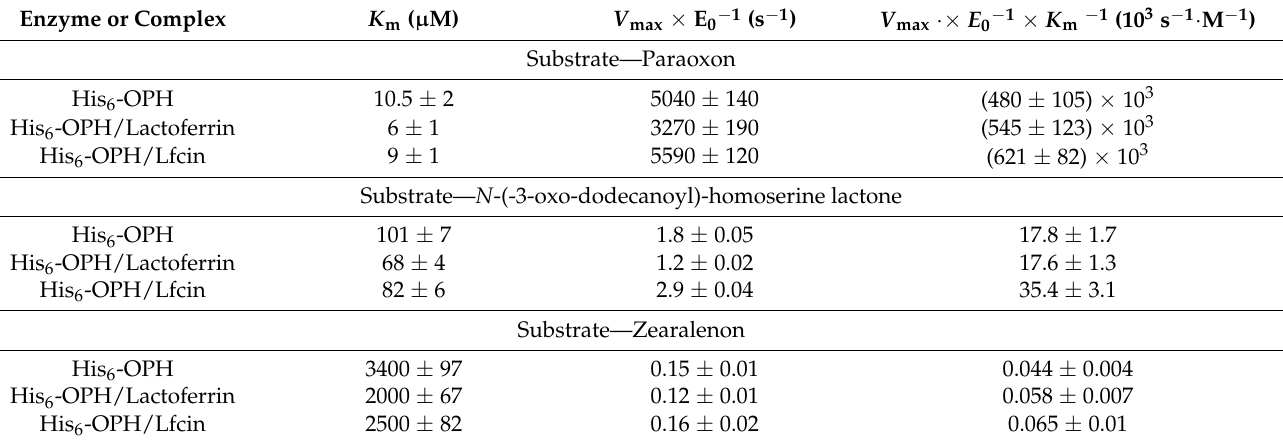
Table 3. Catalytic characteristics of His 6 -OPH in combination with bovine lactoferrin and Lfcin